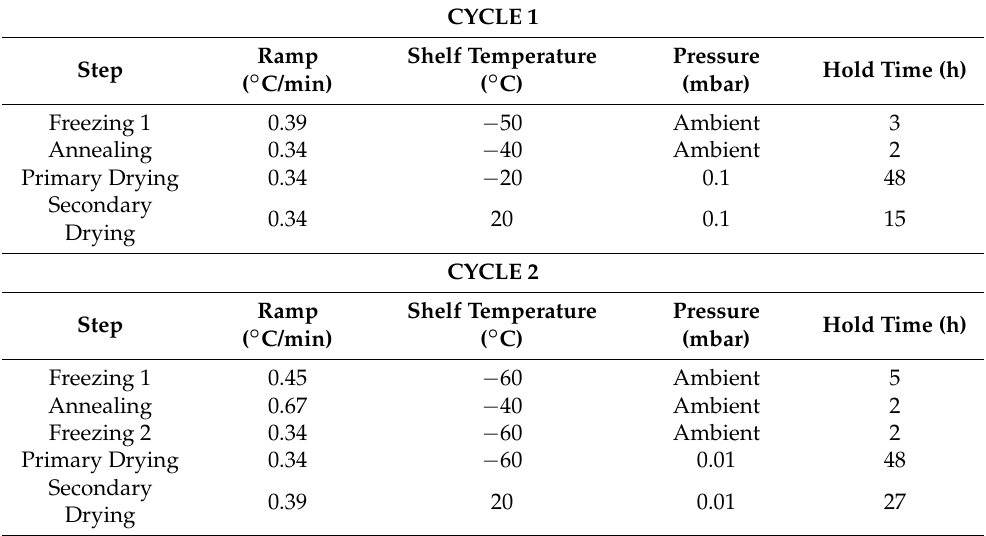
Table 4. Parameters used in cycles 1 and 2 of freeze-drying of LCFL-PTX/DXR with annealing step